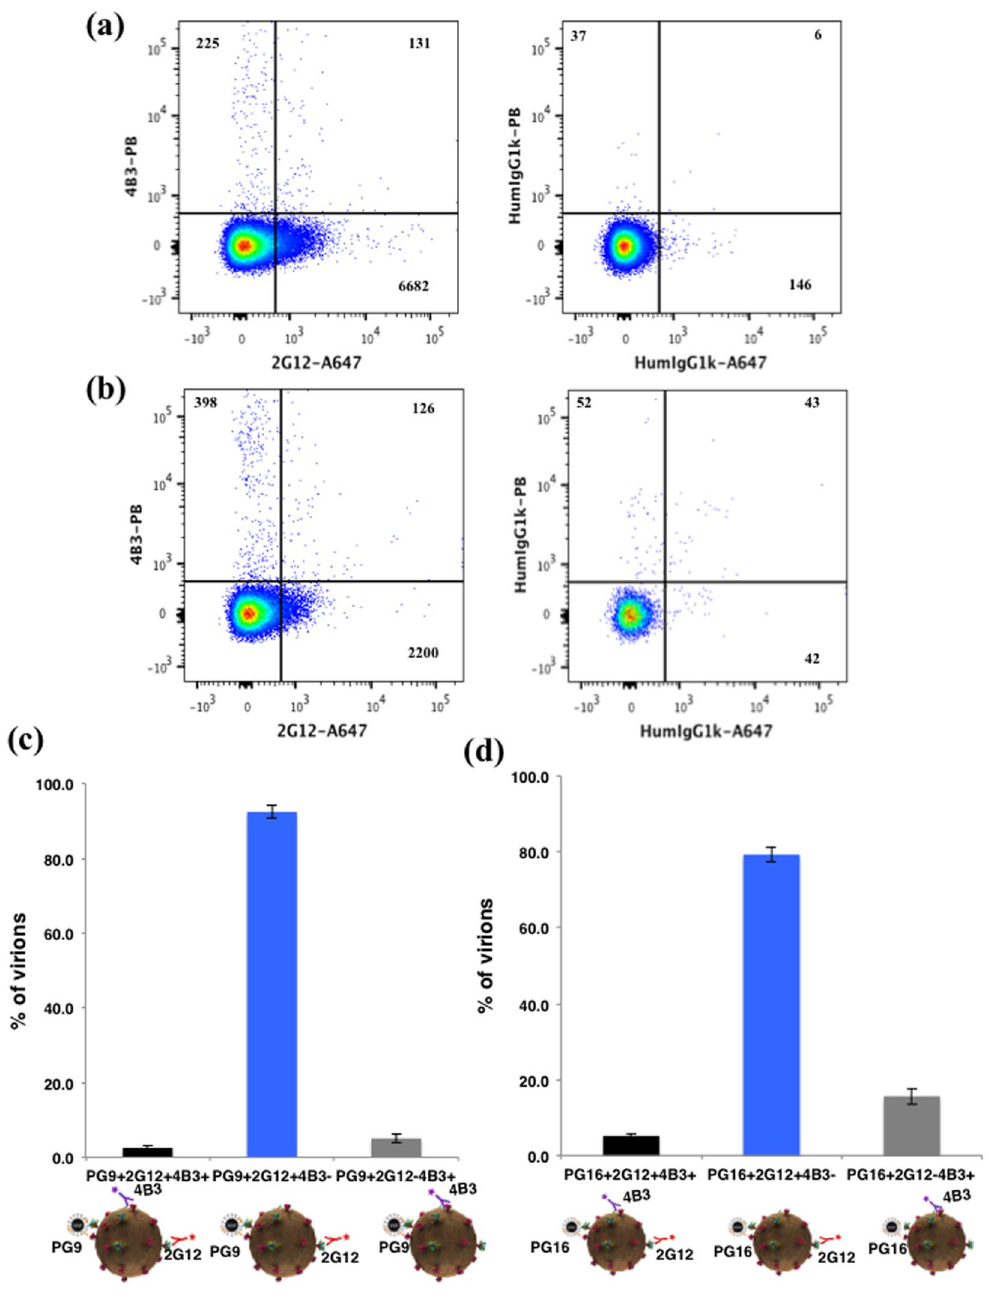
Figure 4. Flow virometry of HIV-1 BaL virions captured with PG9- or PG16-MNPs. ( a ) Virions were captured with PG9-MNPs and stained with two antibodies: AlexaFluor 647-labeled 2G12 and Pacific Blue-labeled 4B3 (left panel) or with isotype control antibodies (right panel). A representative experiment out of three is shown. ( b ) Virions were captured with PG16-MNPs and stained with two antibodies: AlexaFluor 647-labeled 2G12 and Pacific Blue-labeled 4B3 (left panel) or with isotype control antibodies (right panel). A representative experiment out of three is shown. ( c , d ) Distribution of PG9-captured ( c ) and PG16-captured ( d ) virions recognized by 2G12 and/or by 4B3. Each bar represents mean ± SEM of three